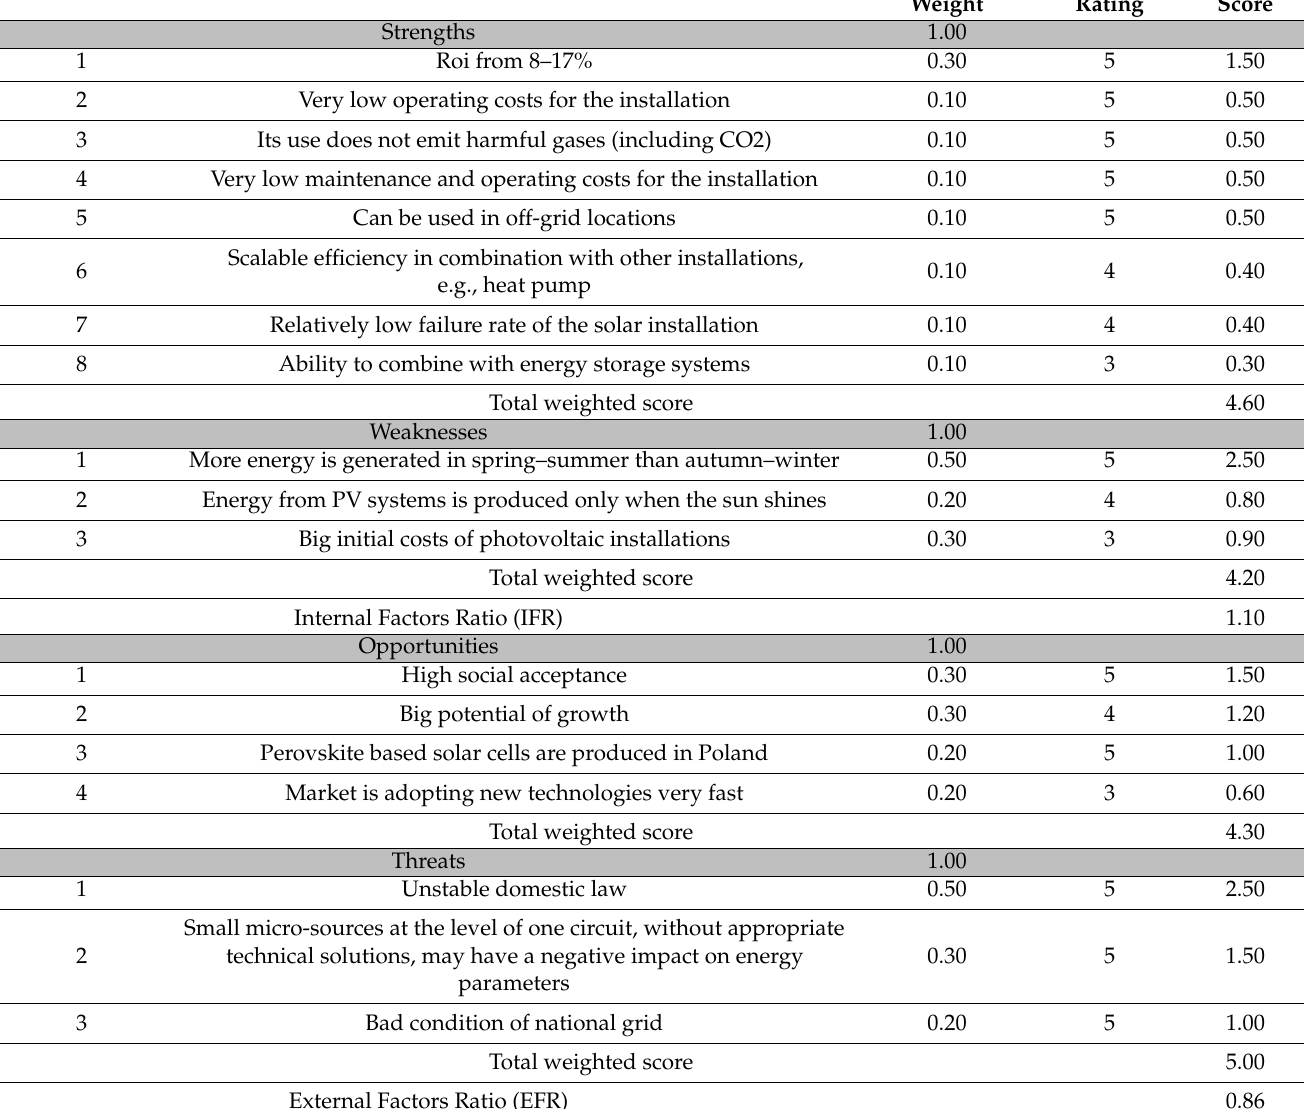
Table 4. Weighted SWOT analysis for photovoltaic systems in